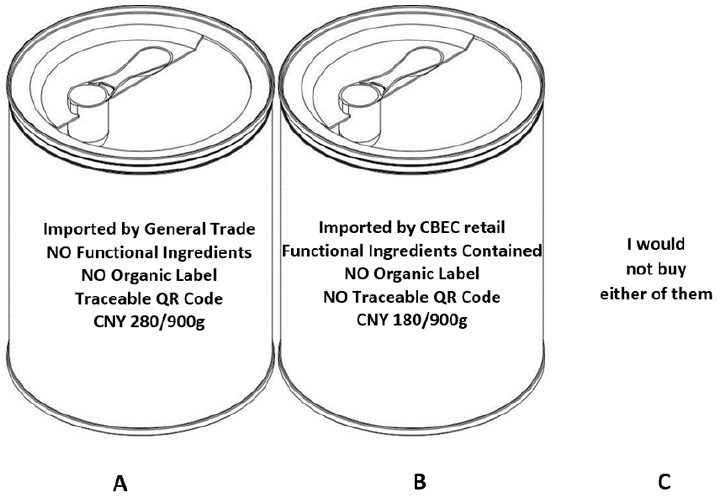
Figure 1. Example of one choice set (A, B, C stand for different options).